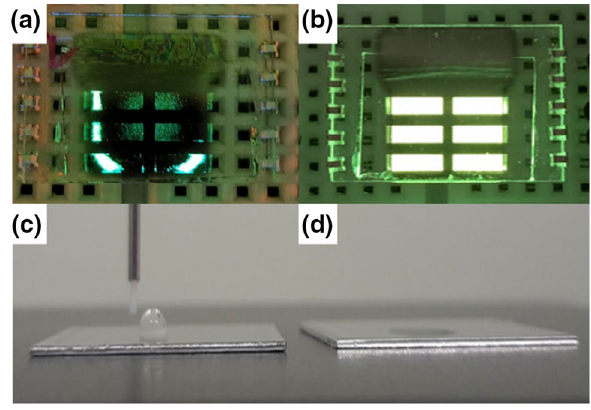
Fig. 4 Upper row: photograph of an OLED (ITO 100 nm/PEDOT:PSS 50 nm/F8:F8BT(19:1) 80 nm/Aluminium 100 nm), a spin-coating of PEDOT:PSS without UV/O -treatment of ITO, b spin-coated 3 PEDOT:PSS after 10 min of UV/O -treatment of ITO; bottom row: 3 photograph of a water droplet on a PDMS coated aluminium sur- face with a size of 1 × 1 cm; c before UV/O -treatment, d after 3 30 min of UV/O